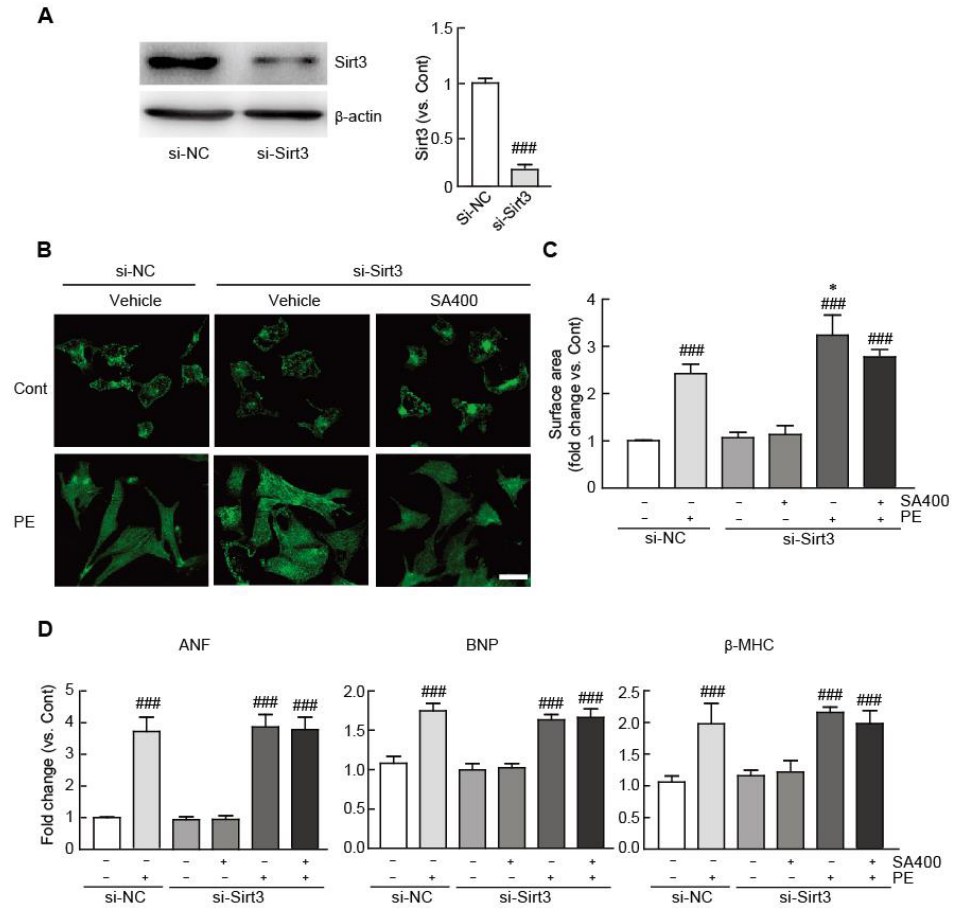
Figure 7. The anti-hypertrophic effect of SA is abrogated in Sirt3-silenced hypertrophic cardiomyocytes. ( A ) The expression level of Sirt3 was measured by Western blot analysis in the cardiomyocytes transfected with control siRNA or Sirt3 siRNA. The band densities were measured by using NIH ImageJ software. β -actin was used as a loading control. ( B ) Representative photograph of control siRNA- or Sirt3 siRNA mixture-transfected cardiomyocytes pretreated with 400 µ M SA and treated with 100 µ M PE. Sarcomeric organization was visualized by α -actinin staining. Scale bar, 50 µ M. Cell surface areas were measured by using NIH ImageJ software ( n = 100 cells per group). ( C ) qRT-PCR analysis of ANF, BNP, and β -MHC mRNA expression. The analyses were performed in triplicate, using three independent samples. Data are expressed as the mean ± standard error of the mean (SEM). Significance was assessed by one-way analysis of variance (ANOVA) with a Bonferroni post hoc test. ### P < 0.005 vs. the control group; * P < 0.05 vs. the control siRNA-transfected group treated with